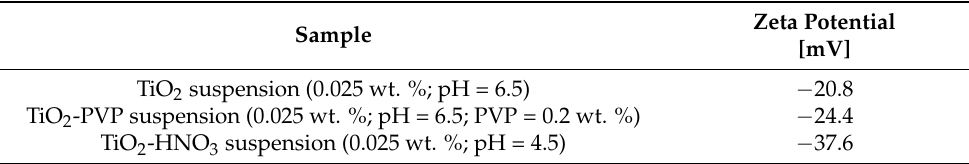
Figure 4. TSI values for the di ff erent prepared suspensions. Table 3. Zeta potential values for TiO 2 suspensions with and without additives.